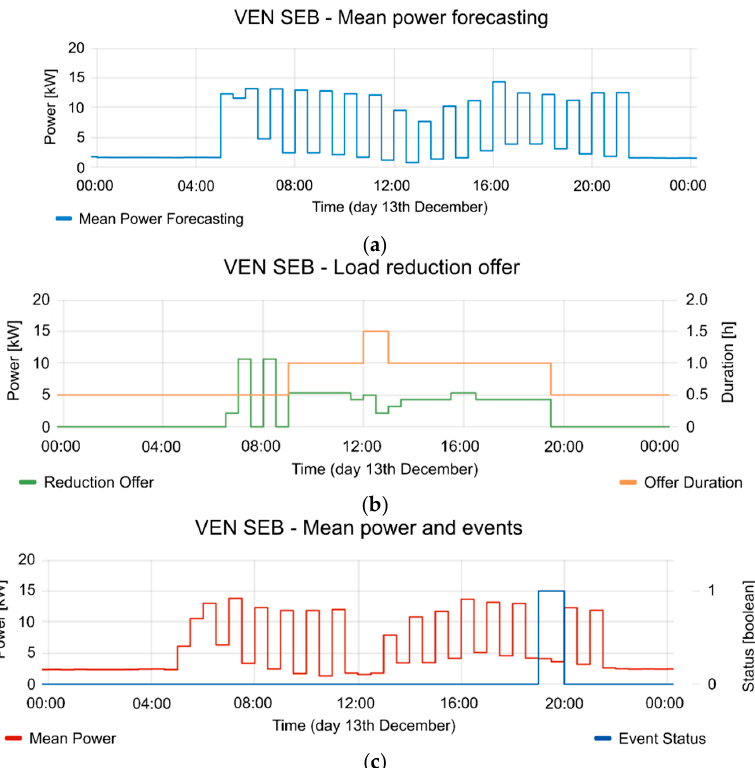
Figure 21. Detailed information from 13 December event. ( a ) mean power forecasting; ( b ) reduction offer and offer duration; ( c ) mean power and event status (where 1 is active and 0 is inactive).